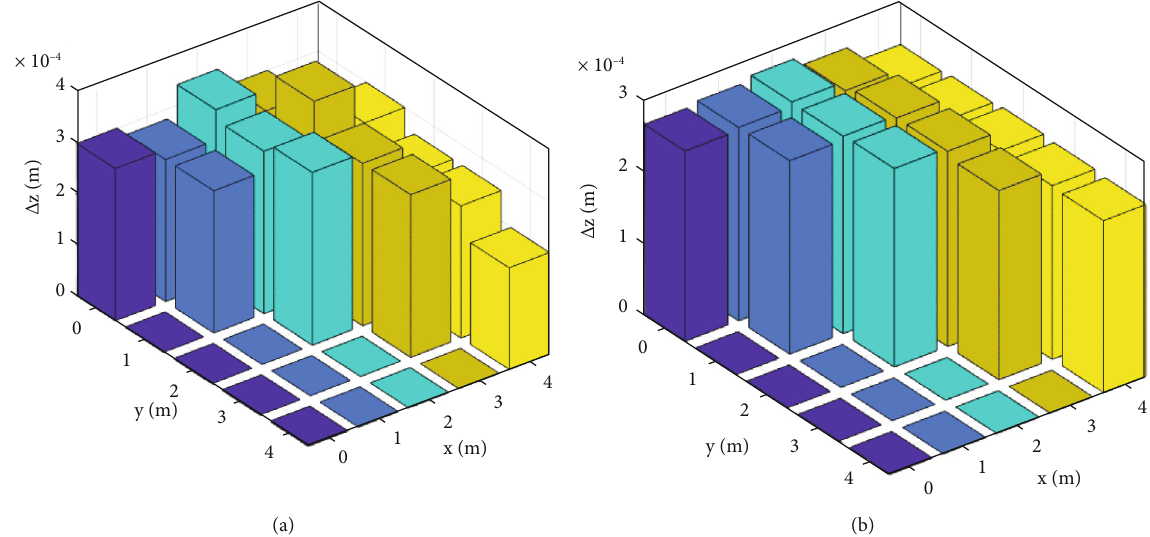
Figure 10: Surface error of front cable net considering the e ff ect of gravity. (a) Optimization results. (b) Finite element calculation